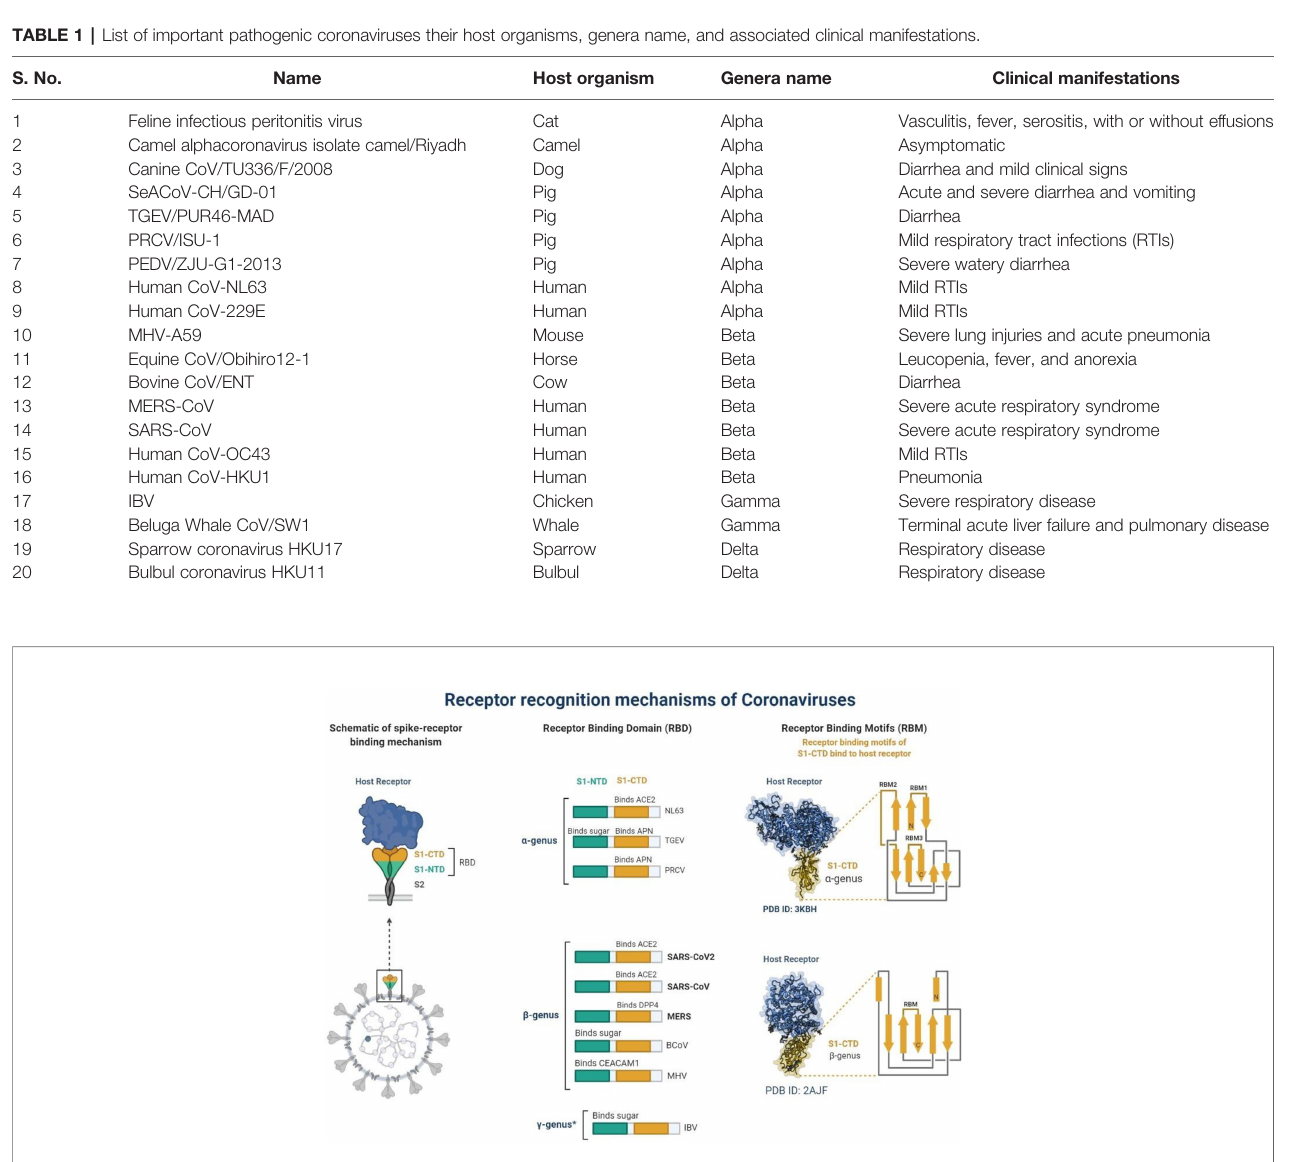
FIGURE 1 | Schematic representation of receptor recognition and binding, spike receptor binding mechanism, receptor binding domain and receptor binding motifs. * g -genus is belong to Avian infectious bronchitis virus (IBV).